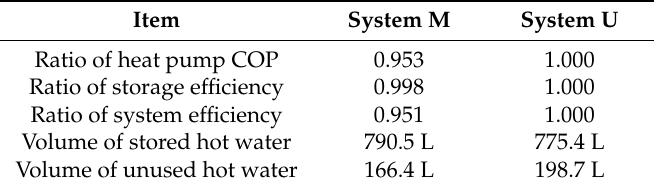
Table 3. Comparison in system performance values between systems M and U.